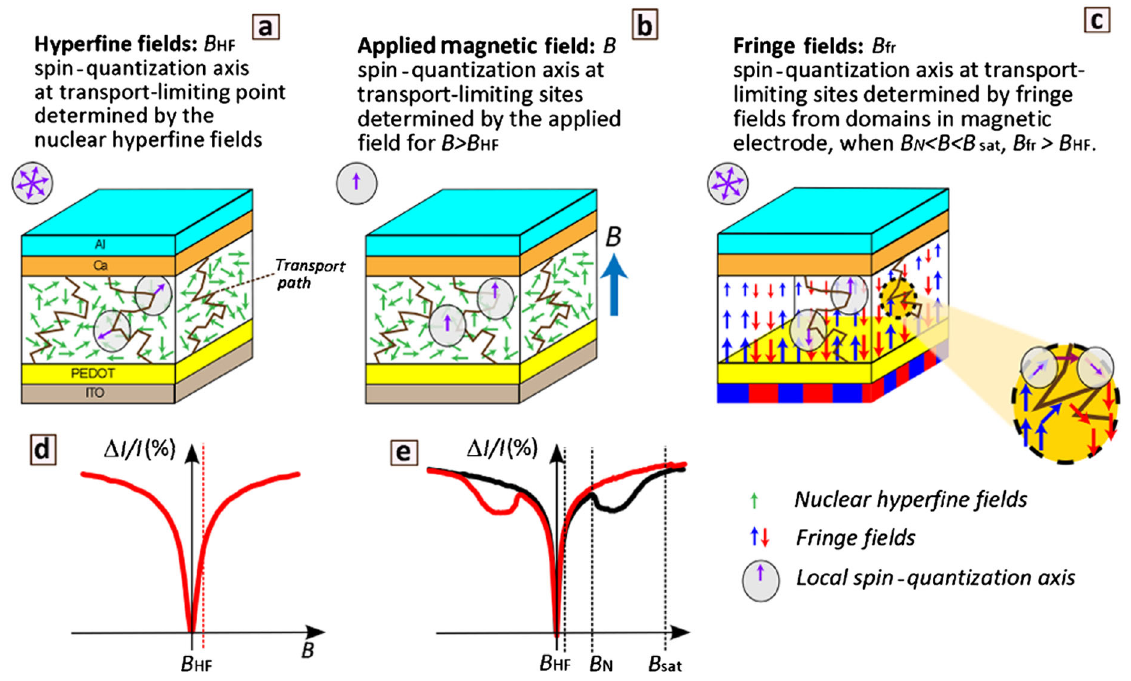
FIG. 7. Comparison of the magnetic fringe-field control of magnetoresistance with nonmagnetic organic magnetoresistance. (a) Transport along a hopping path (brown line) through the organic film is affected by variations in the local spin-quantization axis along the path. (The local spin-quantization axis shown by purple arrows.) (b) An applied magnetic field that exceeds the hyperfine field provides a uniform local spin-quantization axis in the film, enhancing transport. (c) The magnetic electrode produces inhomogeneous local fields that define a local spin-quantization axis independently of the nuclear-hyperfine field. (d) Magnetoresistance for a nonmagnetic organic device, showing a low-field regime and a high-field regime. (e) Magnetoresistance for the semi–spin valve, showing in addition an intermediate field